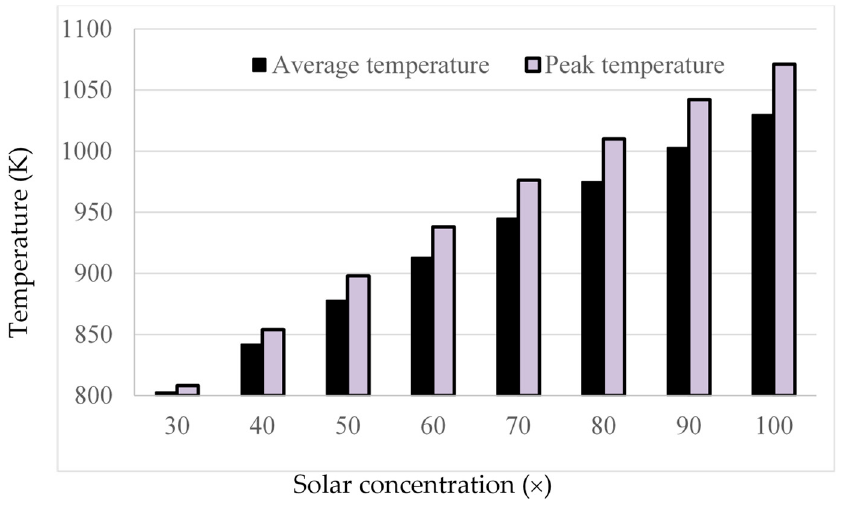
Figure 18. Average and peak temperatures for different solar concentrations.